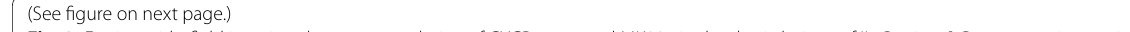
Fig. 2 Ex vivo wide‑field imaging shows accumulation of CXCR4‑targeted MK007 in dysplastic lesions of IL1B mice. A Representative ex vivo fluorescence imaging of three IL1B mice injected with MK007 (left) and one non‑injected 12‑month‑old IL1B mouse (right, upper row), which had a dysplasia score of 3. The different dysplasia score (1–3) is reported. The quantification of ex vivo Sulfo- Cy5 signal by CTCF in mouse stomach and organs 4 h post‑injection showed peptide accumulation also in liver, kidney, and spleen (right, middle row). Target‑to‑background ratio (TBR) of injected mice was 2.45 0.24 compared with negative control (1.26). TBR was calculated as reported in Methods. Data in both graphs are ± represented as mean SEM ( n 5). B Representative confocal images of areas from squamocolumnar junction (SCJ), squamous, and glandular ± = epithelium of the IL1B mouse with dysplasia score 2 in 2A showed less or no Sulfo‑Cy5 signal in non‑dysplastic areas than dysplastic areas